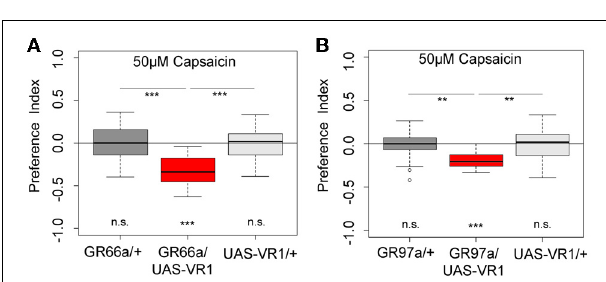
FIGURE 5 | Artificial activation of small set of GRNs or of the single C3 neuron is sufficient to induce an aversive choice behavior. Expression of the mammalian vanilloid receptor protein (VR1) allowed to quantify the behavioral relevance of GR66a-GAL4- and GR97a-GAL4-positive neurons after capsaicin-dependent activation. (A) Experimental GR66a/UAS-VR1 larvae avoided a 50 µ M capsaicin agarose mixture against pure agarose ( p < 0 . 001). The behavioral response was significantly different than the appropriate genetic controls ( p < 0 . 001 each) that did not avoid capsaicin (n.s.). (B) Activation of a single GRN C3 in the TO in GR97a/UAS-VR1 experimental larvae induced an aversive capsaicin-dependent choice behavior ( p < 0 . 001) that was significantly different from both genetic controls ( p < 0 . 01 for both controls). Thus, activation of the single GRN C3 is sufficient to elicit gustatory-guided choice behavior. Sample size for each box plot is n > 12. Differences against zero are given at the bottom of each panel. Differences between experimental groups are depicted above the respective box plots (n.s., non-significant p > 0 . 05, ∗∗ p < 0 . 01, and ∗∗∗ p < 0 . 001). Small circles indicate